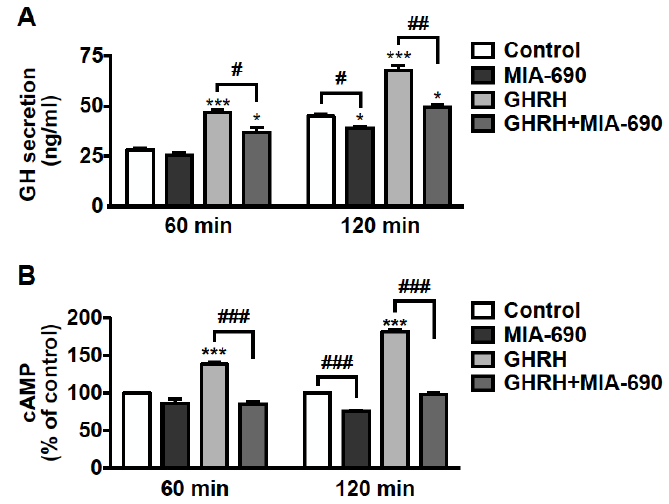
Figure 6. Inhibitory effect of MIA-690 on GH secretion and cAMP levels in GH3-GHRHR cells. ( A ) GH secretion assessed by ELISA in cells cultured in serum-deprived medium for the times indicated and in either absence (Control) or presence of 0.1 µm MIA-690, alone or in combination with 0.1 µm GHRH(1 – 44)NH 2 . Results are means ± SEM. * p < 0.05, *** p < 0.001 vs. Control; # p < 0.05, ## p < 0.01 by unpaired Student ’ s t -test ( n = 3). ( B ) Intracellular cAMP levels assessed by ELISA in cells untreated (Control) or treated with MIA-690 (0.1 µm) or GHRH (0.1 µm), either alone or in combination, for the times indicated. Results, expressed as percent of control for each time point, are means ± SEM of three independent experiments performed in triplicate. *** p < 0.001 vs. control, ### p < 0.001 by unpaired Student ’ s t -test.